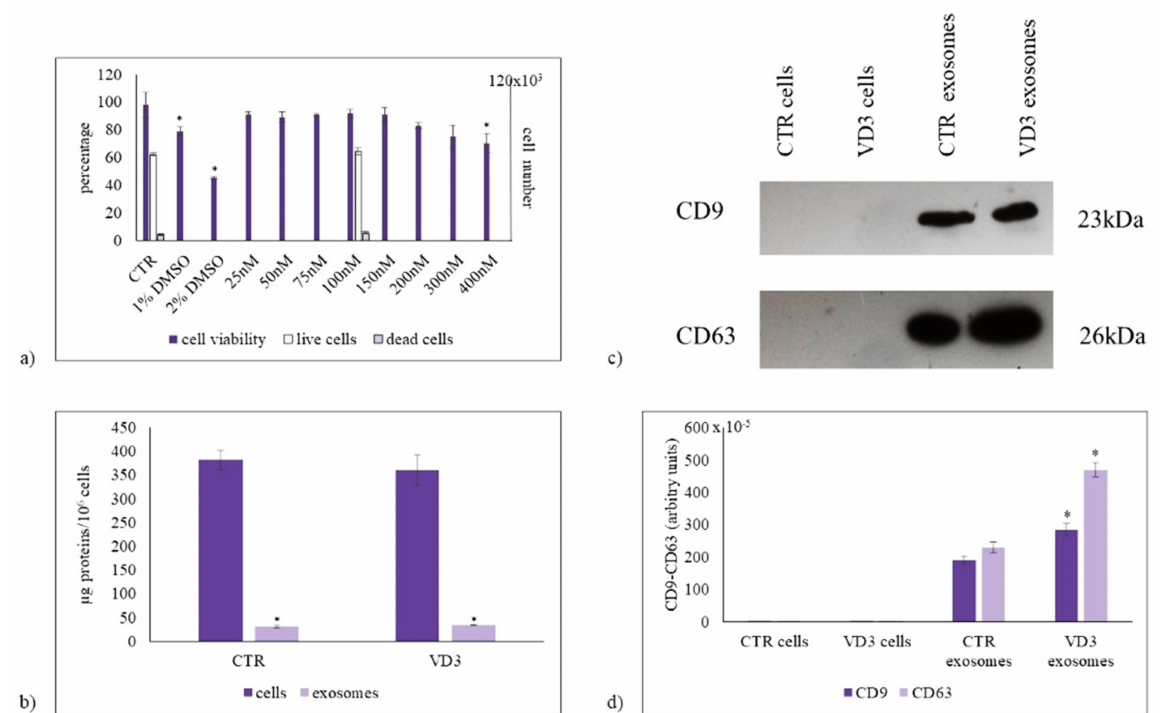
Figure 1. The effect of vitamin D3 on cell viability and exosome purification. ( a ) Left ordinate, effect of VD3 on HN9.10 cell viability (in gray). Cells were cultured with increasing doses of VD3 from 25 nmol/L to 400 nmol/L for 24 h and the viability was measured by MTT assay. Values were reported as percentage viability of the control sample (CTR). 1% DMSO and 2% DMSO were used as positive controls; right ordinate, live cells (in white) and dead cells (in light violet) under 100 nmol/L VD3 treatment evaluated by trypan blue exclusion assay; ( b ) Protein content in cells and exosomes; ( c ) Immunoblotting analysis of CD9 and CD63, as markers of exosome purification. The position of the 23 kDa for CD9, and 26 kDa for CD63 was evaluated in relation to the molecular-weight size markers. ( d ) The area density was quantified by Chemidoc Imagequant LAS500 by specific IQ programm. (case number:6) CTR, control sample; VD3, vitamin D3 sample. Data were expressed as mean ± SD of three independent experiments performed in duplicate. * p < 0.05 versus the control